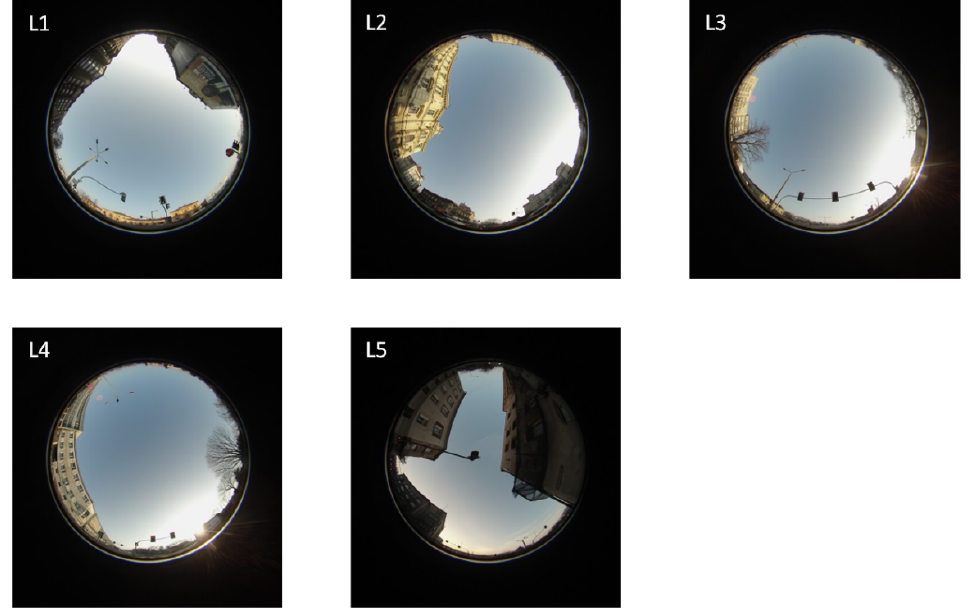
Table 5. The SVF values determined for the locations analyzed.